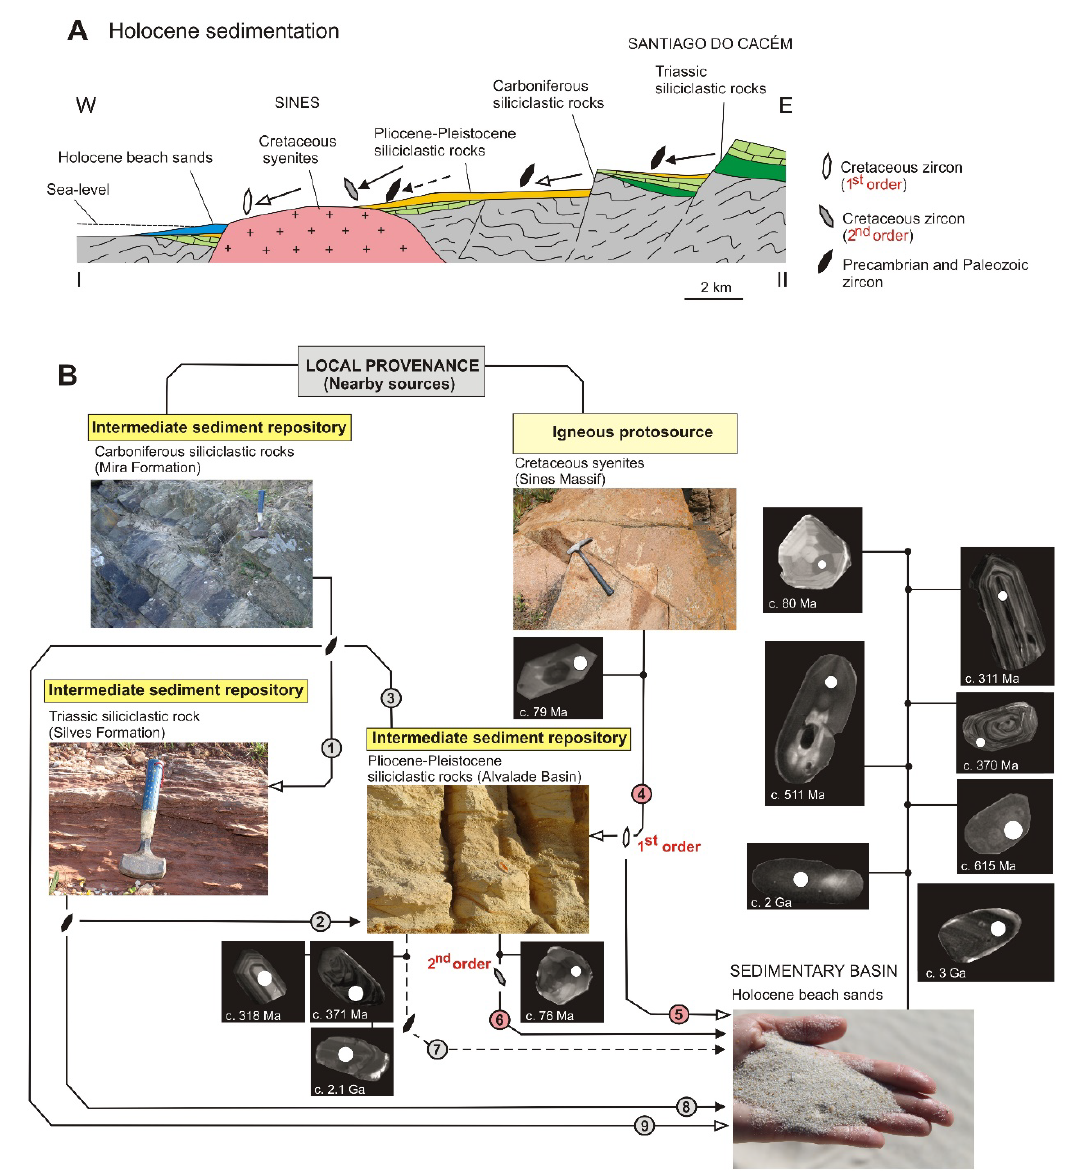
Figure 6. ( A ) Schematic geological cross-section I–II (see location and legend in Figure 2) showing the provenance of the Sines Holocene beach sands. ( B ) Flow diagram illustrating the different zircon provenance ages and the possible delivery pathways into the Sines Holocene beach sands, with cathodoluminescence images of representative zircon grains from the Cretaceous syenite, Pliocene-Pleistocene siliciclastic rocks, and Holocene beach sands [16,28,30].